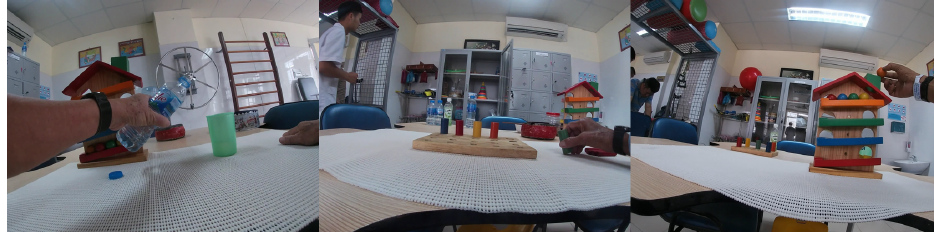
Figure 17. Illustrating the RGB image data obtained from the EV of the RehabHand dataset